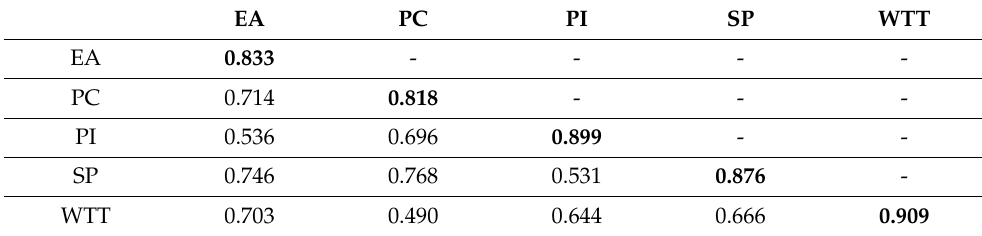
Table 4. Fornell-Larcker